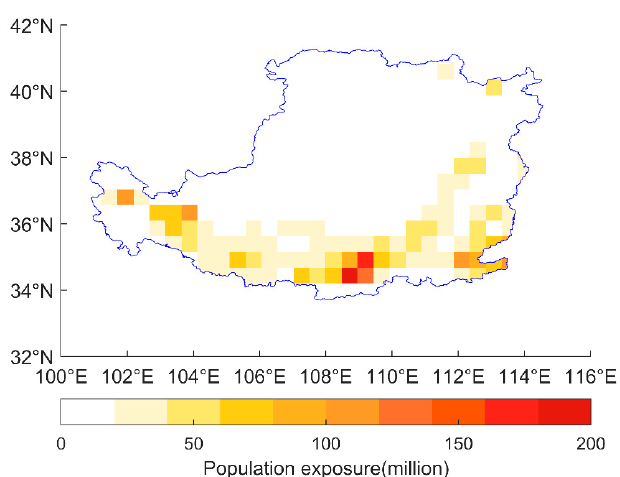
Figure 6. Spatial distribution of the average annual population that is exposed to extreme precipita- tion events on the Loess Plateau at 1.5 ◦ C of global